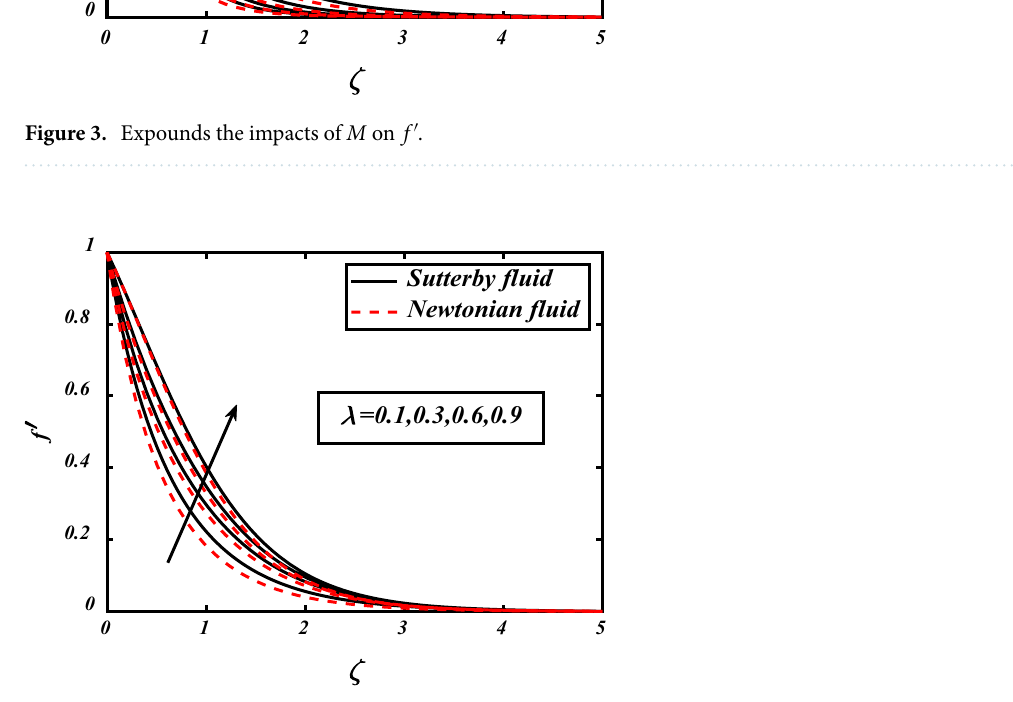
Figure 4. Expounds the impacts of (cid:31) on f ′